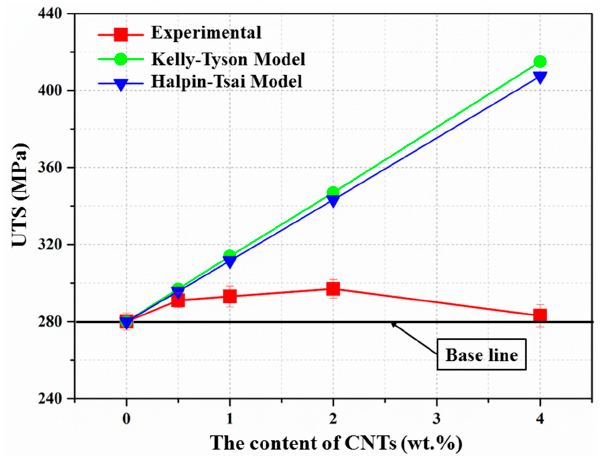
Figure 9. Plots of the ultimate tensile strength (UTS) of the composites theoretically predicted by different models and experimentally obtained in this